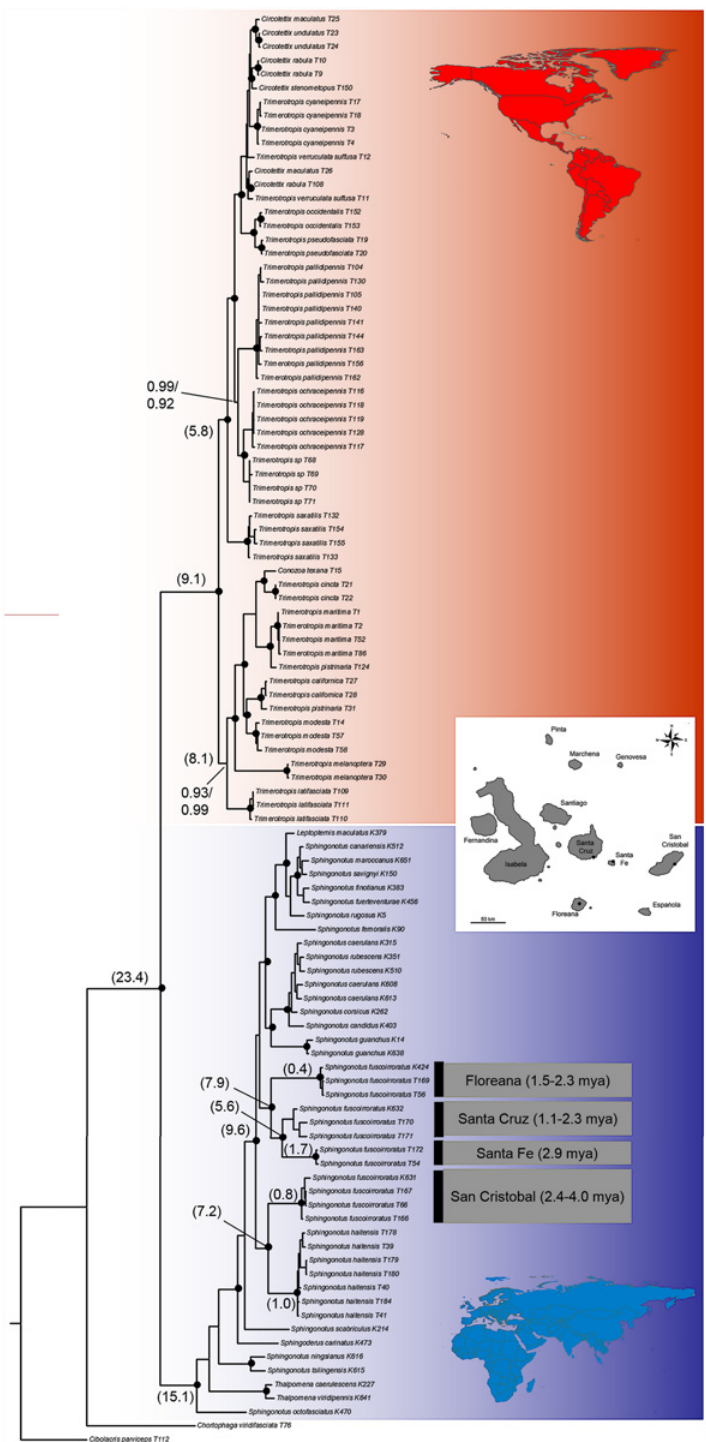
Fig 1. Phylogenetic tree resulting from Bayesian analysis of the combined data set of three genes. Red color indicates the New World Trimerotropini, blue are the Old World Sphingonotini. Black circles represent posterior probabilities (cid:1) 0.95 in both analyses. Numbers are posterior probabilities below 0.95 for at least one of the analyses (upper value from BEAST analysis, lower value from MrBayes analysis). The numbers in parentheses represent the divergence time estimates derived from the BEAST analysis. Only the